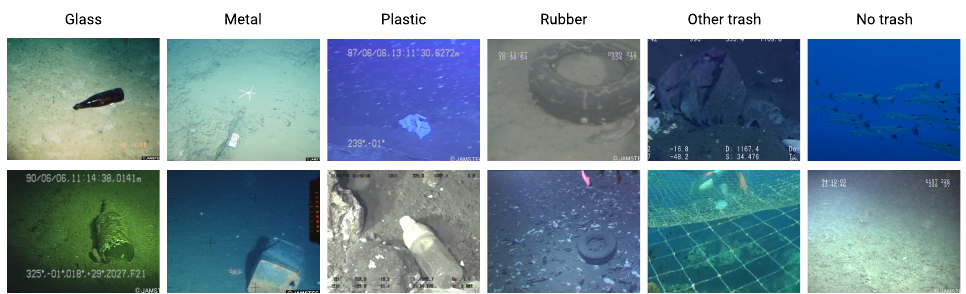
Figure 1. Sample of images from the dataset.